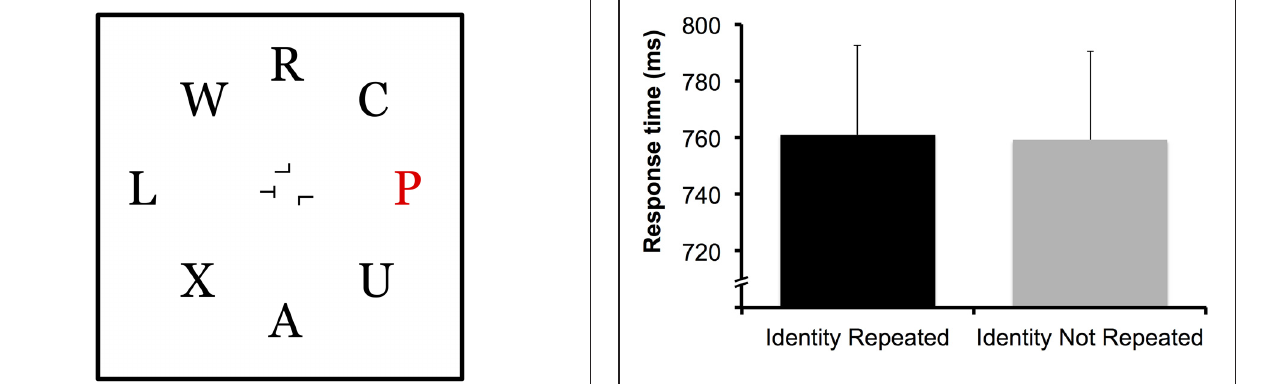
FIGURE 4 | Data from Experiment 2. There was no effect of target identity repetition. Error bars represent 95% confidence interval (e.g., Loftus and Masson,